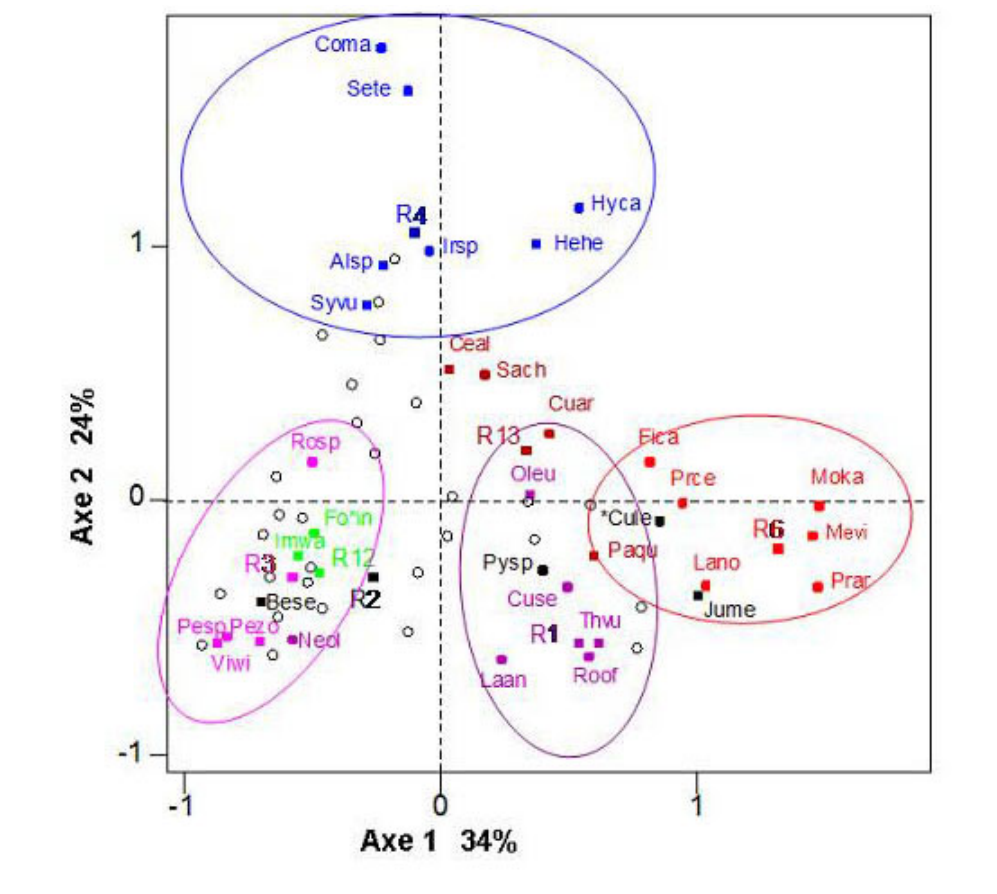
Fig. 6. Two-dimensional graphical representation of the correspondence factorial map for common species and reasons for planting. R1: regional character; R2: resistance-adaptation; R3: esthetics; R4: donation-gift; R6: use; R12: specific flowering; R13: previous presence in garden. Alsp: marshmallow plant ( Althaea sp.); Coma: lily of the valley ( Convallaria majalis ); Cuse: Mediterranean cypress ( Cupressus sempervirens ); Fica: common fig ( Ficus carica ); Hehe: common ivy ( Hedera helix ); Hyca: St. John’s wort ( Hypericum calycinum ); Irsp: Iris sp.; Sete: hens and chicks ( Sempervivum tectorum ); Syvu: common lilac ( Syringa vulgaris ); Lano: bay laurel ( Laurus nobilis ); Laan: lavender ( Lavandula angustifolia ); Mevi: spearmint ( Mentha viridis ); Moka: mulberry ( Morus kagayamae ); Neol: oleander ( Nerium oleander ); Oleu: olive ( Olea europea ); Pezo: “zonal” Pelargonium ; Pesp: Petunia sp.; Prar: apricot ( Prunus armeniaca ); Prce: cherry plum ( Prunus cerastifera ); Rosp: rose ( Rosa sp.); Roof: Rosemary ( Rosmarinus officinalis ); Thvu: thyme ( Thymus vulgaris ); Viwi: pansy ( Viola x wittrokiana